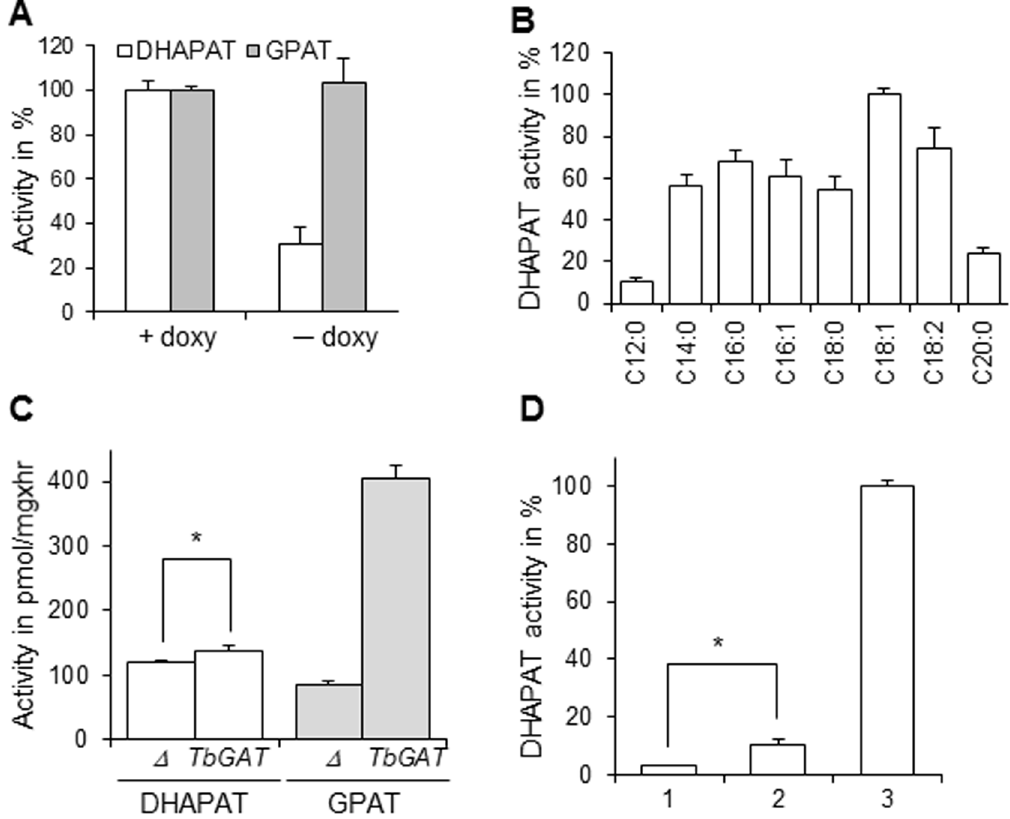
Fig 6. Tb DAT is the main DHAPAT enzyme in procyclic trypanosomes. (A) The GPAT and DHAPAT assays were performed with 0.2 and 1.5 mg proteins derivedfrom wholecell lysates of cells grown in the presence or absence(10 days) of doxycycline, respectively.100% of DHAPAT and GPAT activity corresponds to 5.48 nmol/ minxmg and 1.31 pmol/minxmg, respectively. (B) Fatty acyl-CoA specificity of remainingDHAPAT activity in Δ tbdat/ Δ tbdat/TetO : V5 : TbDAT grown in the absenceof doxycycline for 10 days. The values were normalizedto the best fatty acyl-CoA donor oleoyl-CoA and 100% DHAPAT correspondsto 0.47 nmol/minxmg. (C) GPAT and DHAPAT activity quantification of Δ lmgat/ Δ lmgat ( Δ ) and Δ lmgat/ Δ lmgat [TbGAT NEO] ( TbGAT ) were carried out in the presenceof 100 μ M and 150 μ M oleoyl-CoA, respectively. * , p value < 0.05. (D) DHAPAT assay with Δ lmdat/ Δ lmdat (1, [25]), Δ lmdat/ Δ lmdat/TbGAT (2), and Δ lmdat/ Δ lmdat/LmDAT (3, [25]). The assay was performed as describedin Materials and methods section in the presenceof 150 μ M oleoyl-CoA and 100% DHAPAT activity correspondsto 1.9 pmol/minxmg. * , p value < 0.05. ( A )( B )( C )( D ) The activity assays were carried out at least twice in duplicateand standarddeviations are